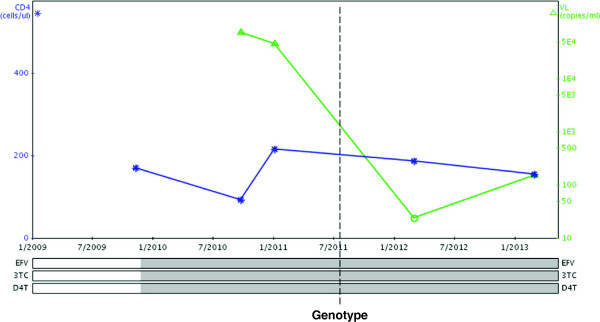
Graphical display of antiretroviral history and viral load/CD4+ cell count measurements (Case example 1).